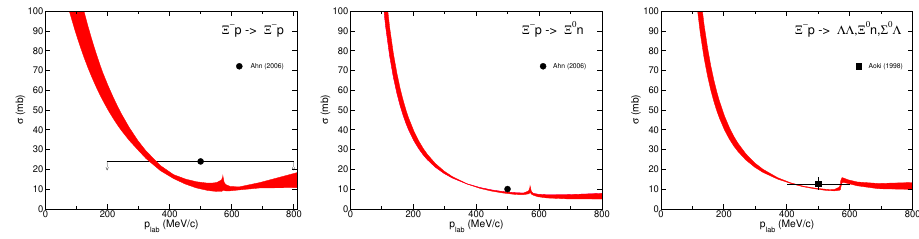
Figure 4. Results for the Ξ N cross sections of our NLO potential [6]. Data are from Refs. [36, 37]. contact terms in other irreps ( { 27 } , { 10 } , { 10 ∗ } , { 8 s } , { 8 a } ), with regard to those determined